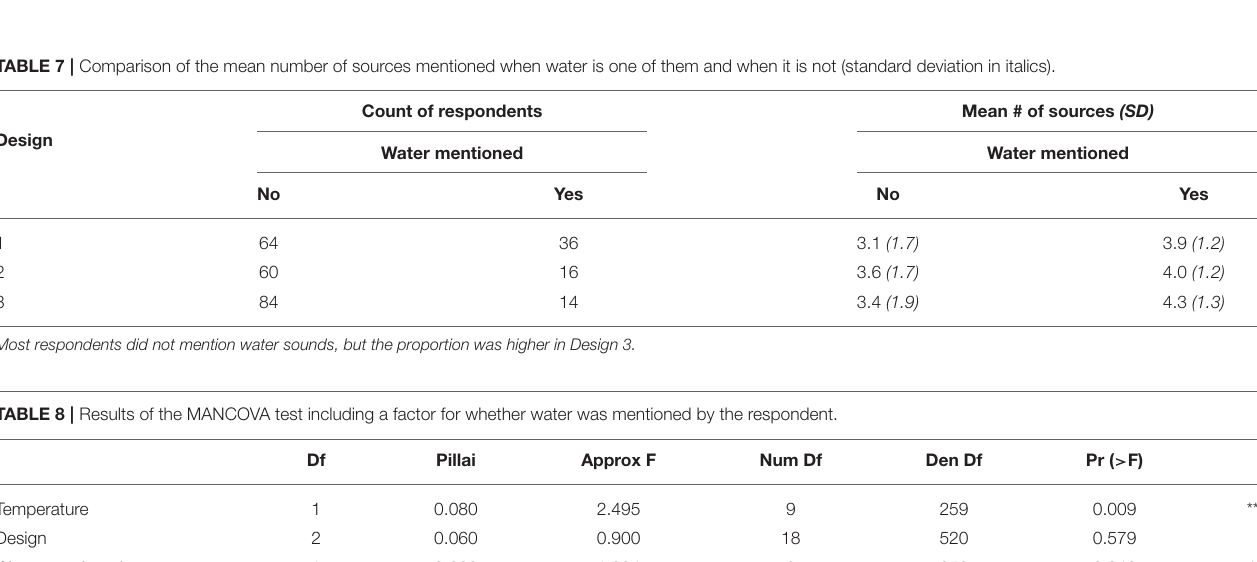
FIGURE 6 | The mean calmness rating increases when the respondent mentions water sounds.